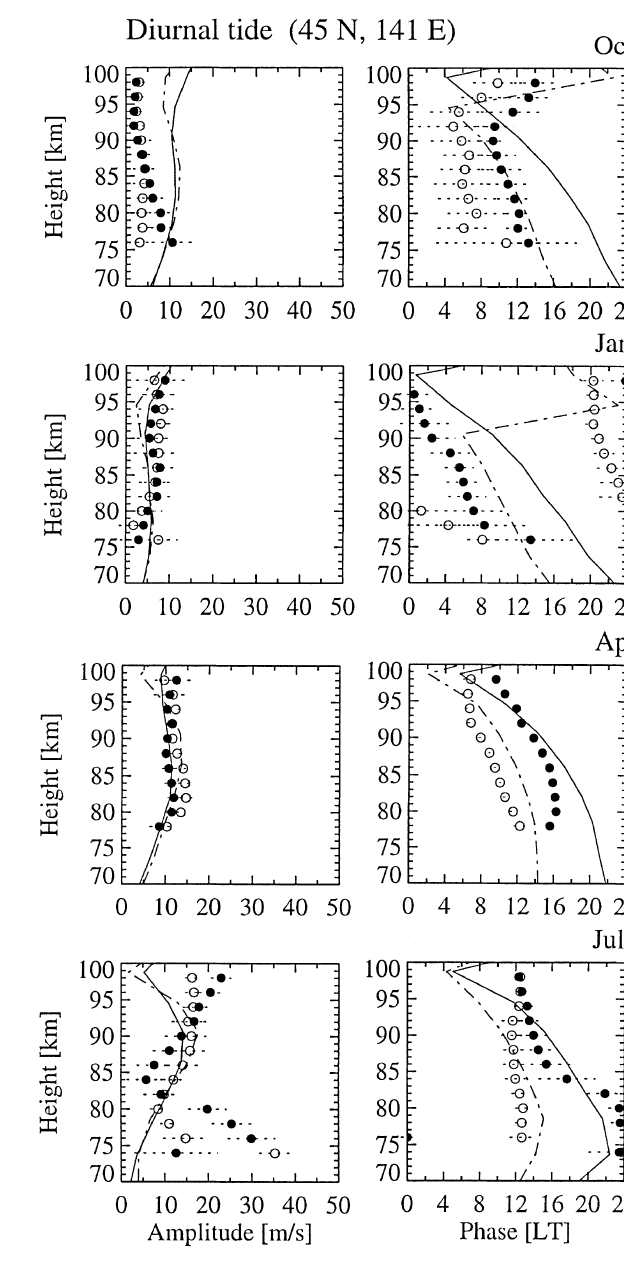
Fig. 6. Same as Fig. 5 but for the diurnal tide at Wakkanai (45